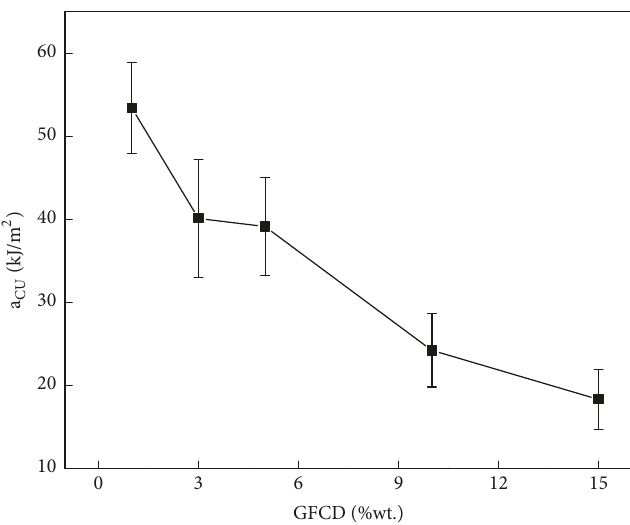
and the GFCD content in PVC. cU